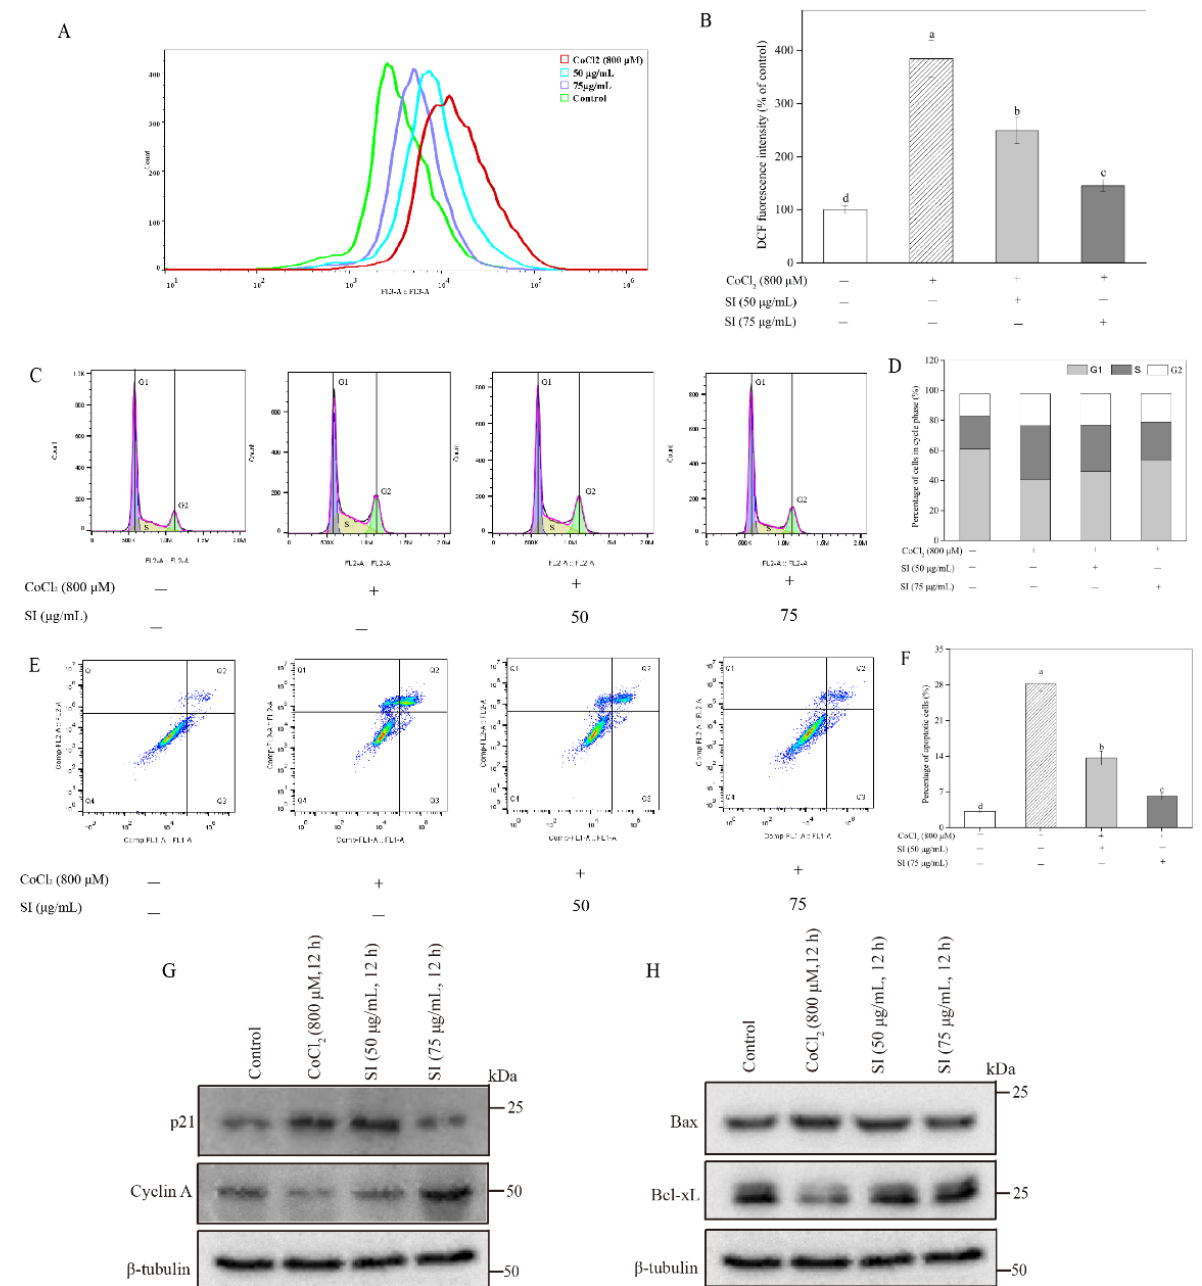
Figure 3. Effects of SI on ROS production, cell cycle arrest, and apoptosis induced by CoCl 2 . ( A ) ROS levels analyzed by flow cytometer. ( B ) Fluorescence intensity in ( A ). ( C ) Cell cycle analyzed by flow cytometer. ( D ) Cell cycle in ( C ). ( E ) Cell apoptosis analyzed using flow cytometer. ( F ) Cell apoptosis rate in ( E ). ( G ) Western blot analysis of p21 and cyclin A proteins. ( H ) Western blot analysis of Bax and Bcl-xL proteins. Means with different small letters were significantly different ( p < 0.05).